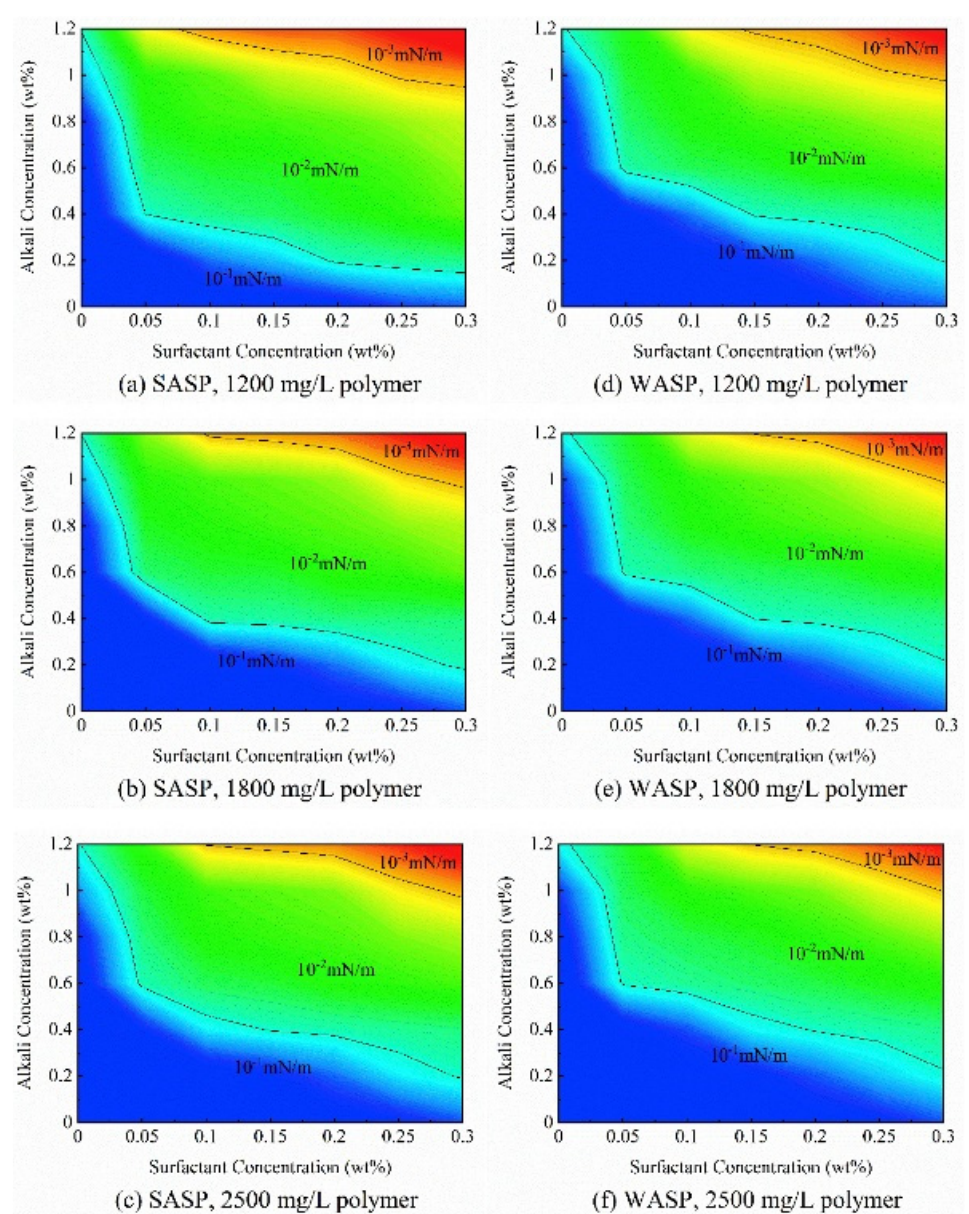
Figure 2. Effects of ASP components on IFT.